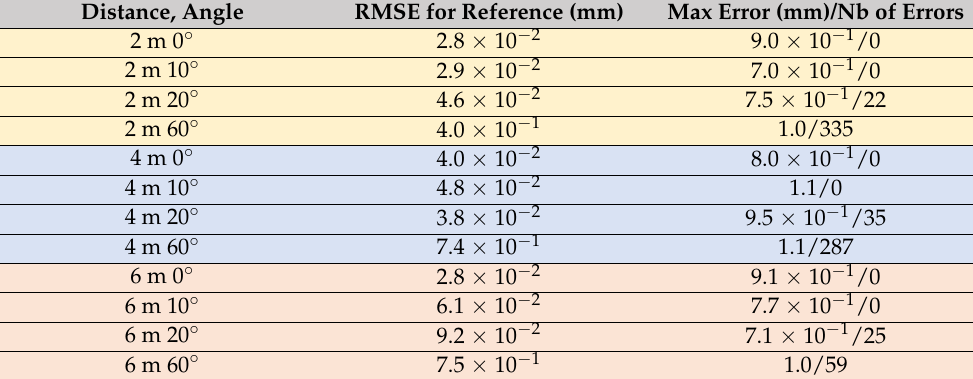
Table 3. Results of the approximation after calibration for different scanning configurations using the reference T-mesh. The same criteria as in Table 1 are chosen to judge the goodness of fit. Distance, Angle RMSE for Reference